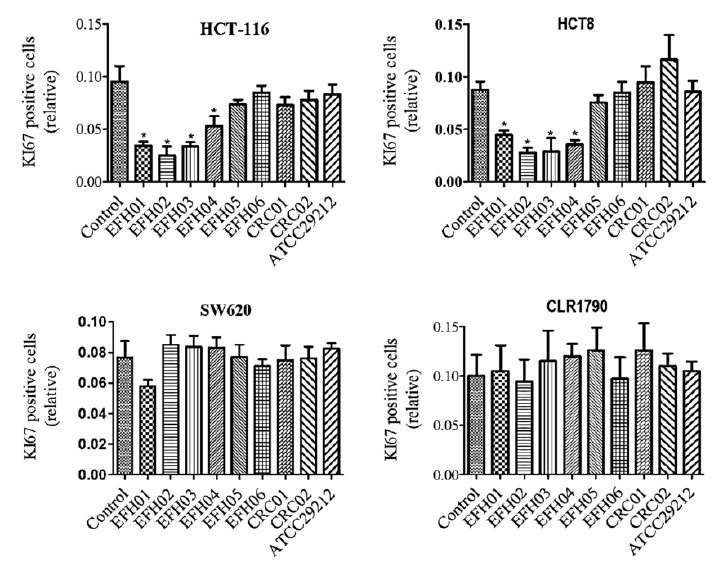
Figure 4. Ki67 positive HCT8, HCT116, SW620, and CLR1790 cells after 72 h of exposure to the metabolites produced from different strains of E. faecalis . Error bars indicate the standard deviation (* p ≤ 0.05).